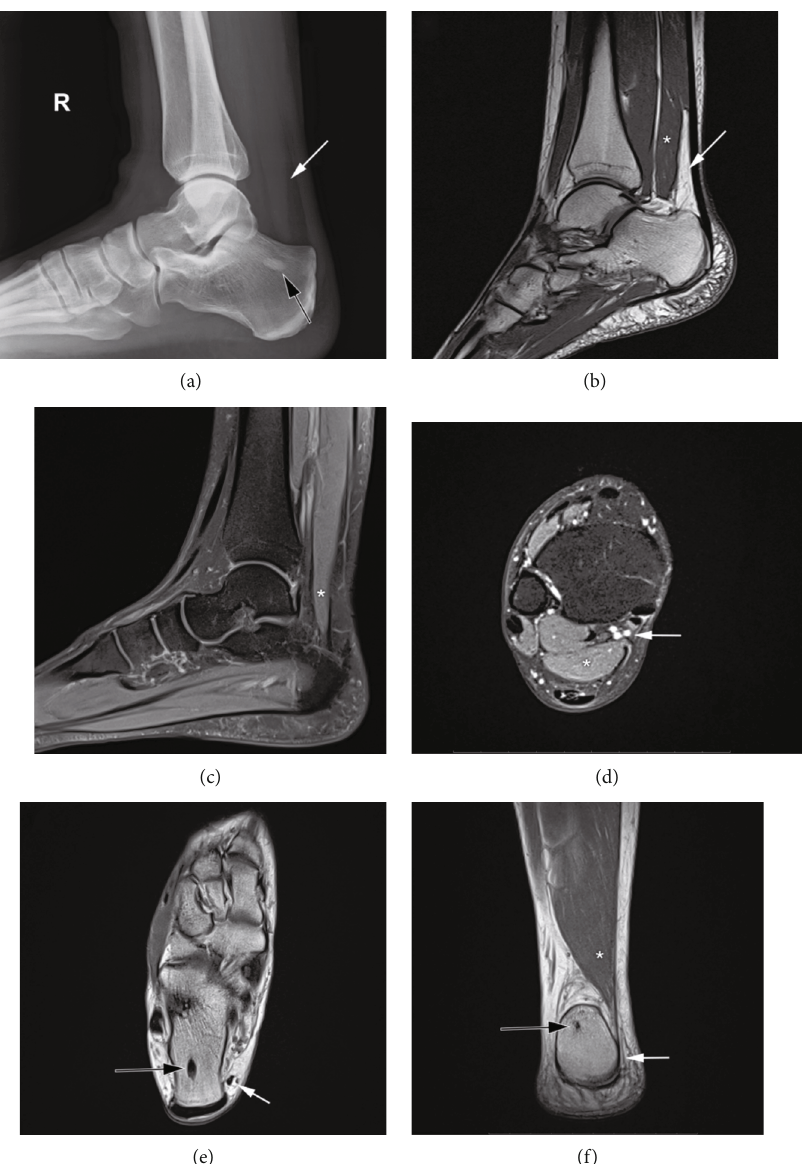
Figure 3: Preoperative images of the patient ’ s right ankle presented in the second case. (a) Obliteration of Kager ’ s fat pad visible on the plain lateral radiograph of the right ankle is pointed by a white arrow, and insula compacta is pointed by a black arrow. (b) T1-weighted sagittal MR image of the right ankle. Accessory soleus muscle (ASM) is marked with an asterisk ( ∗ ), and obliteration of the Kager ’ s fat pad is pointed by a white arrow. (c) T2-weighted sagittal MR image of the right ankle. ASM is marked with an asterisk ( ∗ ), where shrinkage of the muscle can be visualized towards its insertion. (d) T2-weighted axial MR image superior to the right ankle. ASM is marked with an asterisk ( ∗ ). In this plane, the muscle is positioned closest to the neurovascular bundle that is pointed by a white arrow. (e) T1-weighted axial MR image of the right ankle. Tendinous insertion of the ASM on the medial side of the calcaneus is pointed by a white arrow, and insula compacta in the calcaneus is pointed by a black arrow. (f) T1-weighted axial MR image of the right ankle. ASM is marked with an asterisk ( ∗ ), tendinous insertion of the ASM on the medial side of the calcaneus is pointed by the white arrow, and insula compacta in the calcaneus is pointed by a black arrow. No elevation of the skin and subcutaneous tissue is